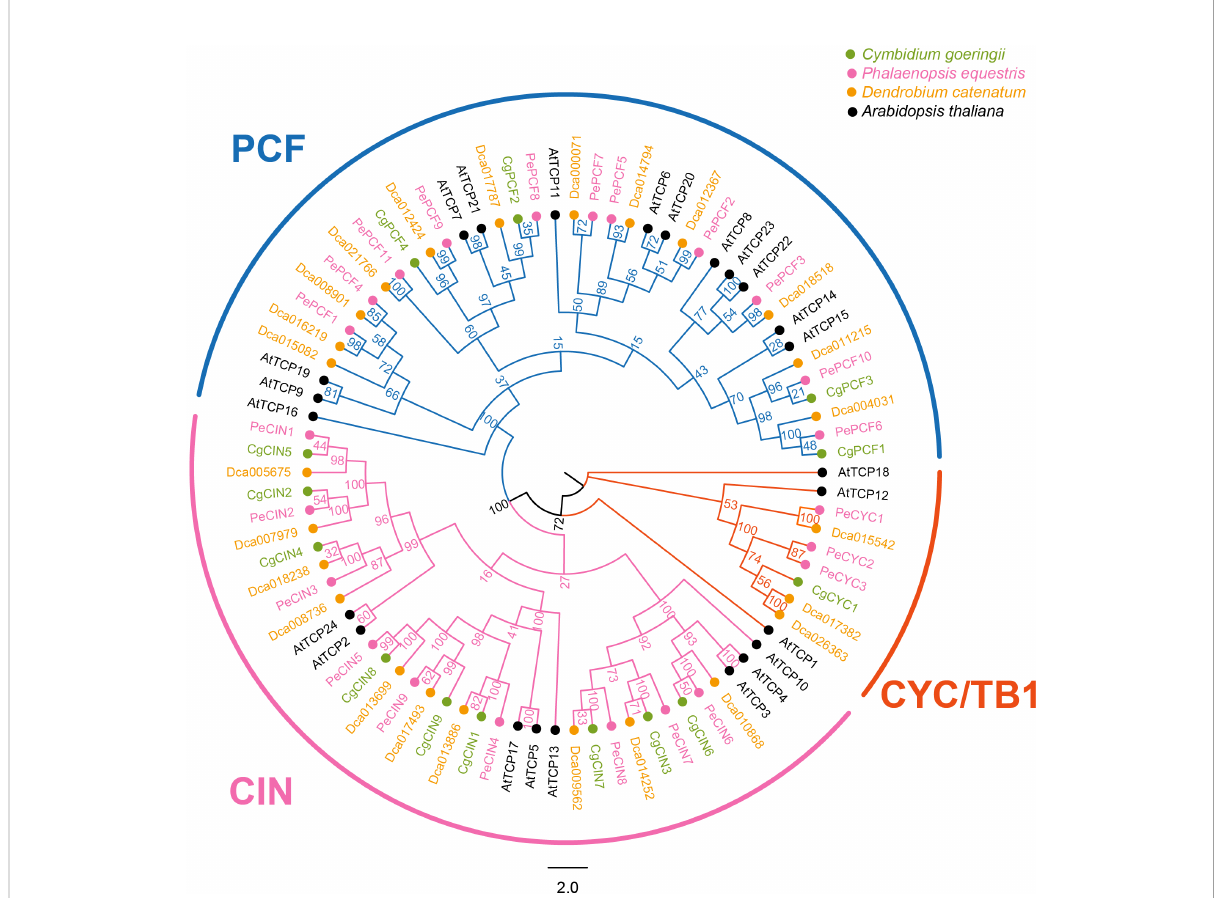
FIGURE 1 Phylogenetic tree based on the TCP protein sequences of Cymbidium goeringii , Phalaenopsis equestris , Dendrobium catenatum and Arabidopsis thaliana . Phylogenetic analysis indicated that the TCP gene family was classi fi ed into the following two clades: Class I (PCF) and Class II (CIN and CYC/TB1); there are two subclades in Class II. TCP protein sequences of C. goeringii are available in the Supplementary Data